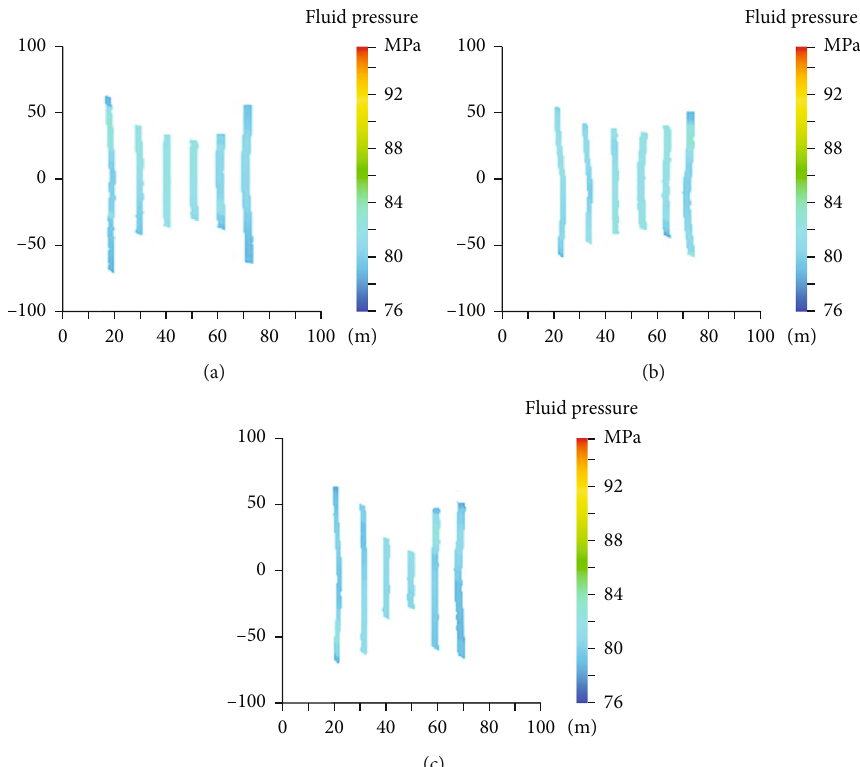
Figure 7: E ff ects of di ff erent perforation distributions on fracture geometry.